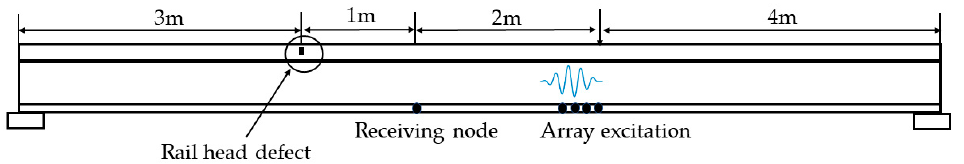
Figure 15. Diagram of the rail head defect detection.